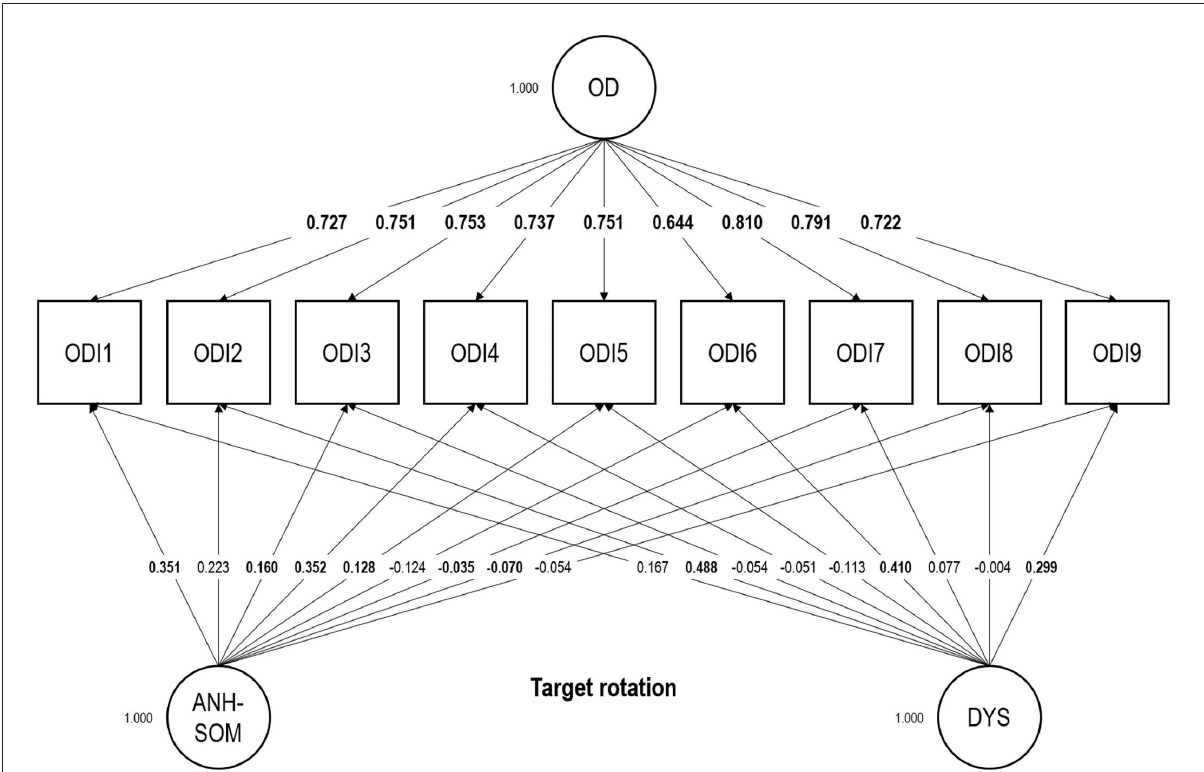
FIGURE1 Exploratory structural equation modeling bifactor analysis of the Occupational Depression Inventory—factor loadings. Target loadings are bolded. OD, general Occupational Depression factor; ANH-SOM, anhedonic-somatic bifactor; DYS, dysphoric bifactor. N = 963 (no missing values); ODI1, anhedonia; ODI2, depressed mood; ODI3, sleep alterations; ODI4, fatigue/loss of energy; ODI5, appetite alterations; ODI6, feelings of worthlessness; ODI7, cognitive impairment; ODI8, psychomotor alterations; ODI9, suicidal ideation.